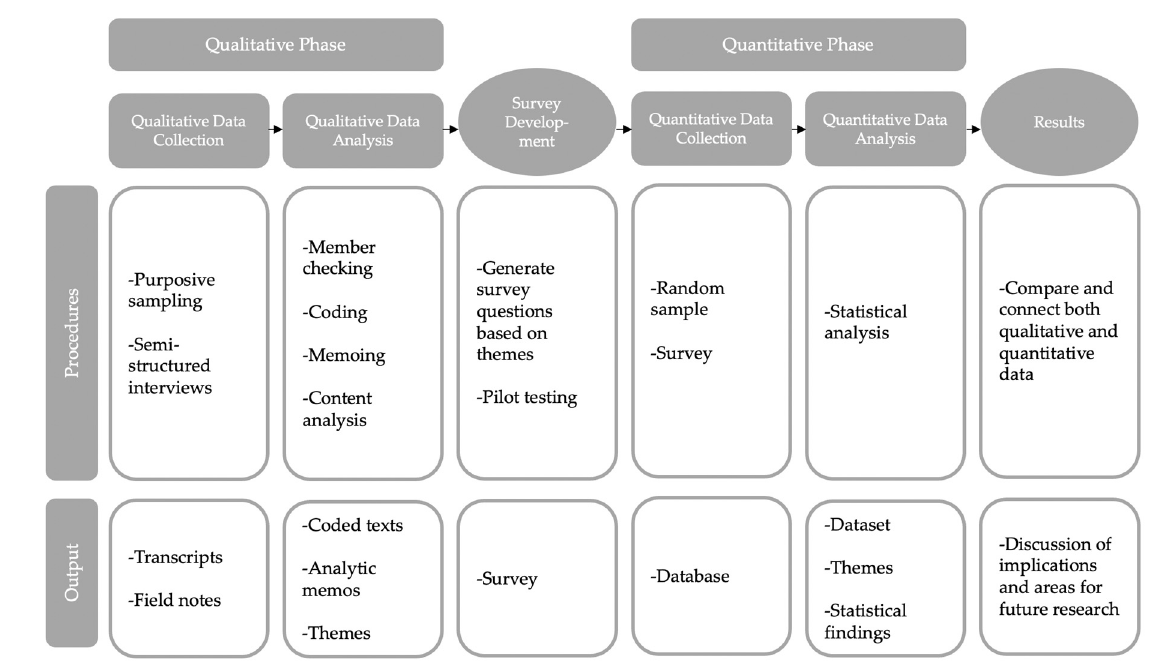
Figure 3. Study design diagram .